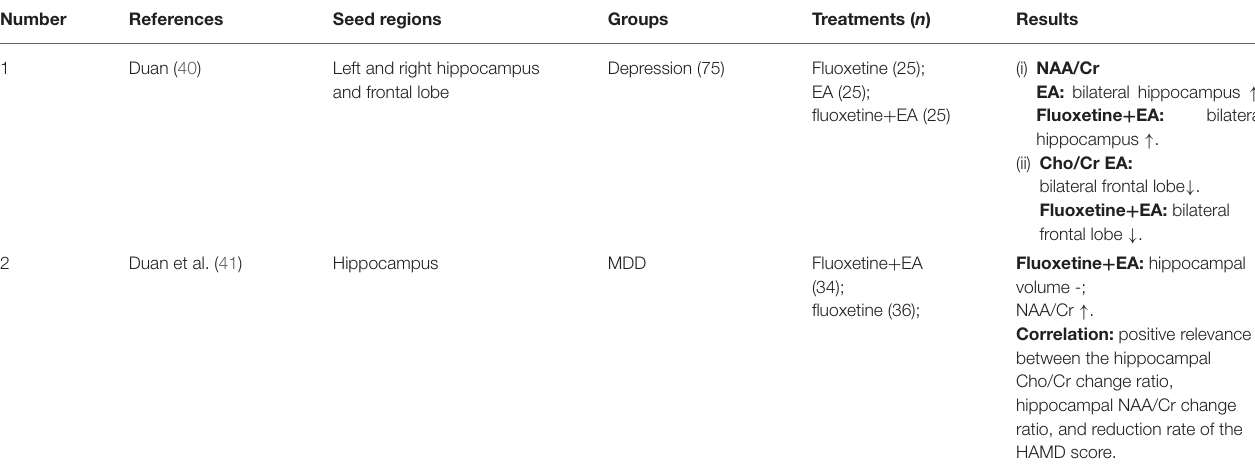
TABLE 3 | 1 H-MRS studies of acupuncture on depression.